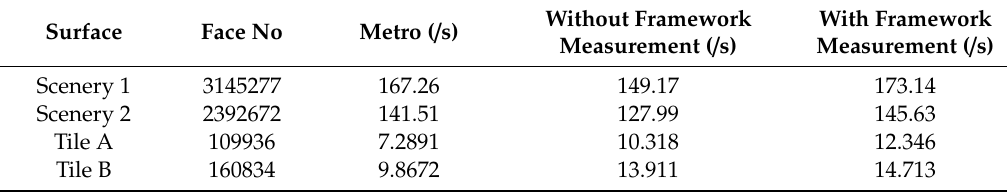
Table 3. Comparison of time performance between Metro and our methods. From the Table, the time performance is close to and even better than that of